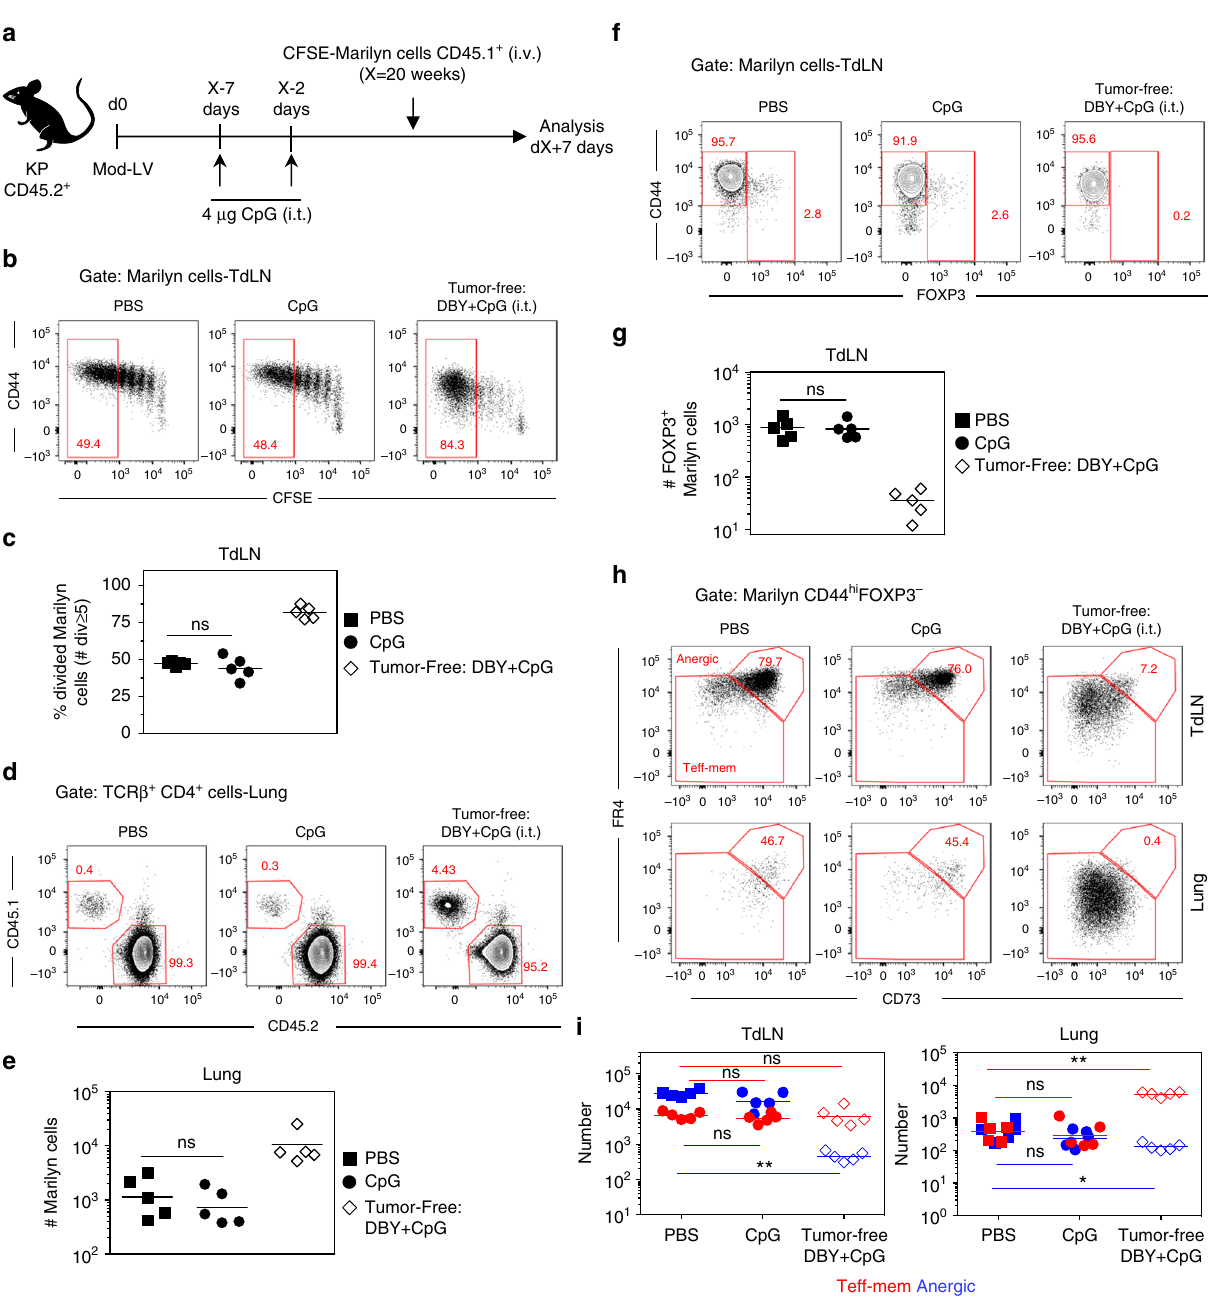
Fig. 5 CpG administration at the tumor site does not restore an effector CD4 + T cell response. a Mice bearing advanced tumors received 4 μ g of CpG twice, at 5-day interval, 2 days before Marilyn cell transfer. b Proliferation pro fi le of Marilyn cells in the TdLN of tumor-bearing mice receiving or not CpG. c Frequency of ≥ 5 times divided Marilyn cells. d Representative plots showing the frequency of Marilyn cells in the lung and e quanti fi cation (number). f Representative plots showing the frequency of FOXP3 + Marilyn cells in the TdLN and g quanti fi cation (number). h Representative plots of FR4 and CD73 expression on CD44 hi FOXP3 − Marilyn cells, and i quanti fi cation (number of anergic or Teff-mem cells). ns: non-signi fi cant, * p <0.05, ** p <0.01 Mann – Whitney U test. One representative experiment out of two is